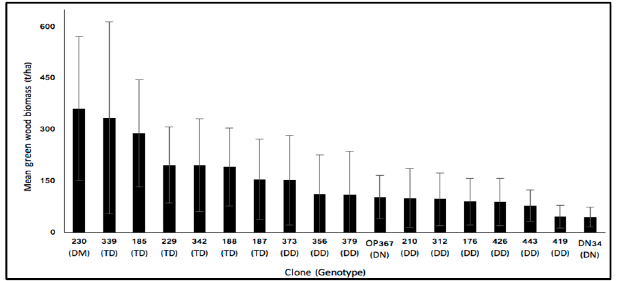
Figure 8. Mean green wood biomass (t/ha) of high-density (10,000 trees/ha) and non-irrigated poplars after 4 years of growth at a study site in the upper Blue Ridge Mountains. Table 3. Results of statistical analyses of the effects of topographic position (upslope vs. downslope) and aspect of the land as well as possible interactions with clones and genomic groups on the wood productivity of poplars.